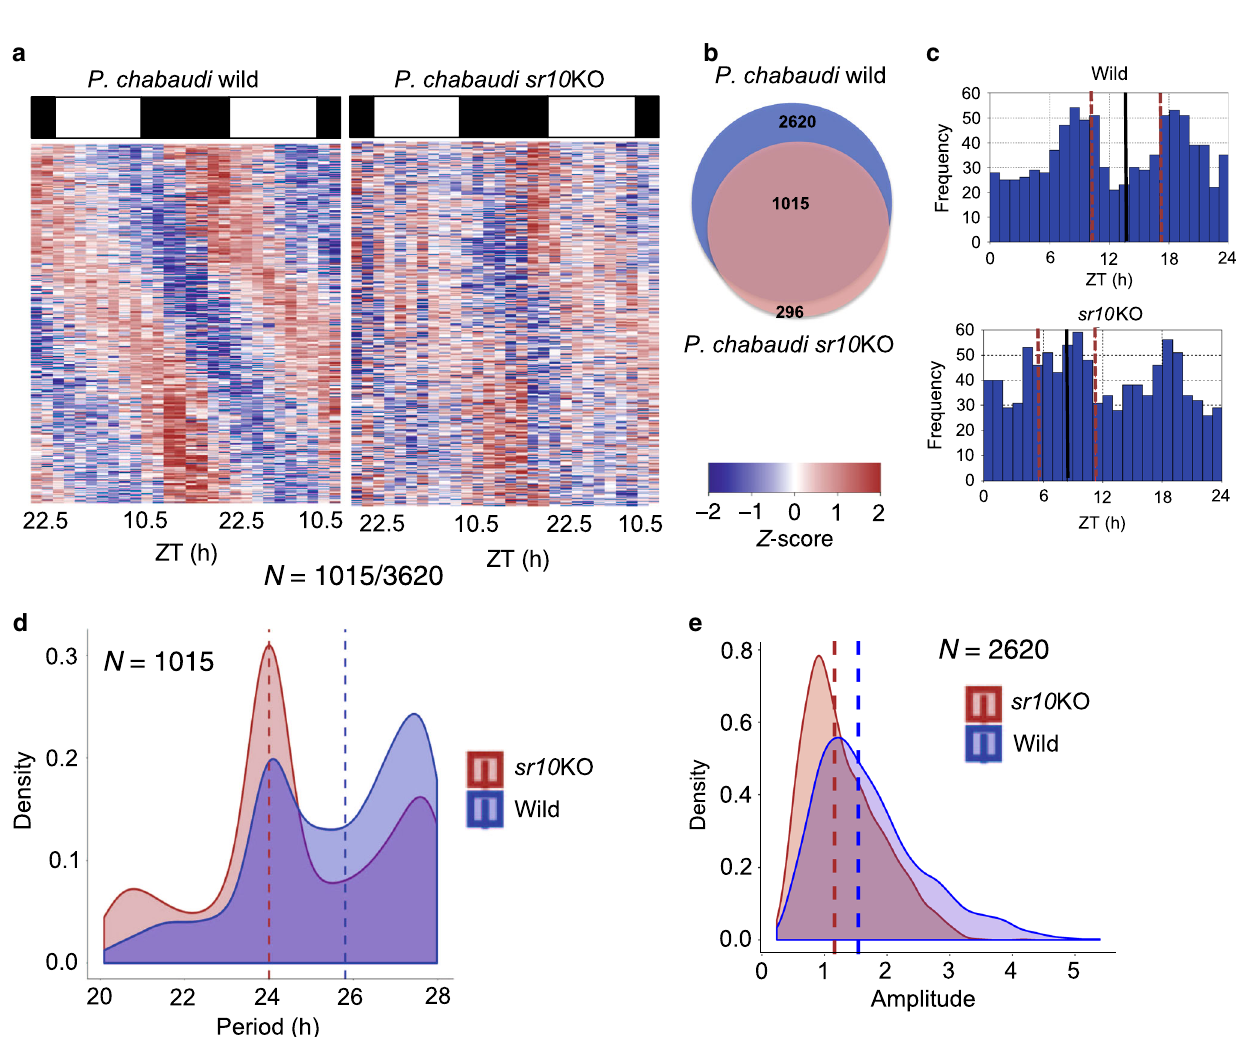
Fig. 4 Disruption of sr10 affects daily rhythms in P. chabaudi gene expression. a Time series gene expression heatmap view of genes expressed with daily rhythmicity in P. chabaudi wild type that lost rhythmicity in sr10 KO parasites. Right most heatmap shows the expression pattern of transcripts that lost rhythmicity in sr 10KO parasites. Each row represents a single gene, sorted according to phase of maximum expression starting from fi rst time point of sample collection. N represents number of genes with 24 h rhythmicity identi fi ed. Each time point is represented by an expression heatmap of two biological replicates. b Venn diagram of number of genes with 24 h rhythmic expression identi fi ed by both JTK and ARSER in wild type and sr10 KO parasites. c Phase distributions of genes with 24 h expression in wild type that lost 24 h rhythmicity in sr10 KO parasites. The mean circular phase for each condition is indicated by a solid black line. N represents the number of cycling transcripts. Pink lines represent standard deviation of the mean circular phases. d Transcripts that displayed with 24 h (putative “ circadian ” ) rhythmicity only in wild type parasites have median periods close to 26 h in wild-type parasites (blue dashed line) and 24 h in sr10 KO parasites (brown dashed line). e Genes that were rhythmic in both wild type and sr10 KO parasites had a signi fi cantly lower mean amplitude in sr10 KO parasites (1.15, brown dashed line) compared to wild type parasites (1.53, p < 0.00001). Source data are provided as Source Data fi